Question: What kind of plot is shown here?
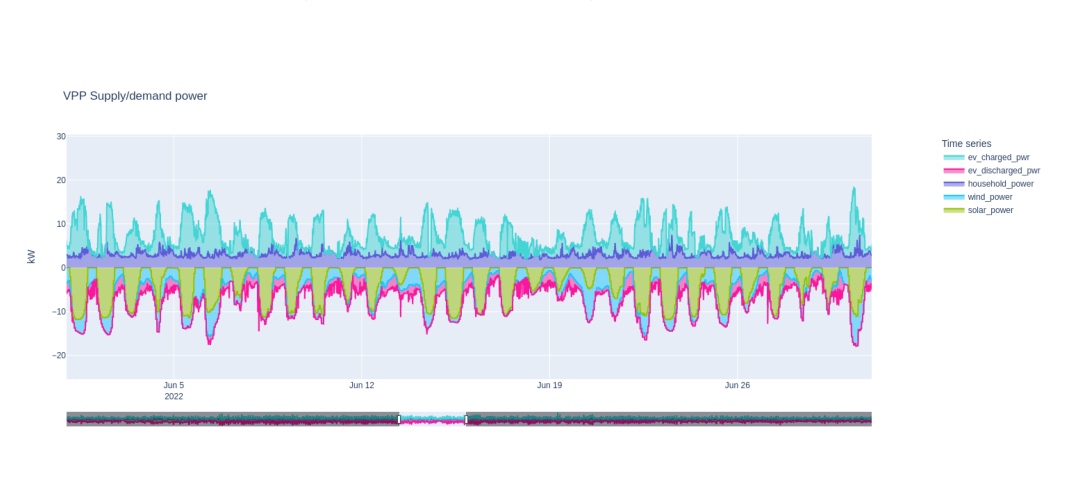
Answer: line